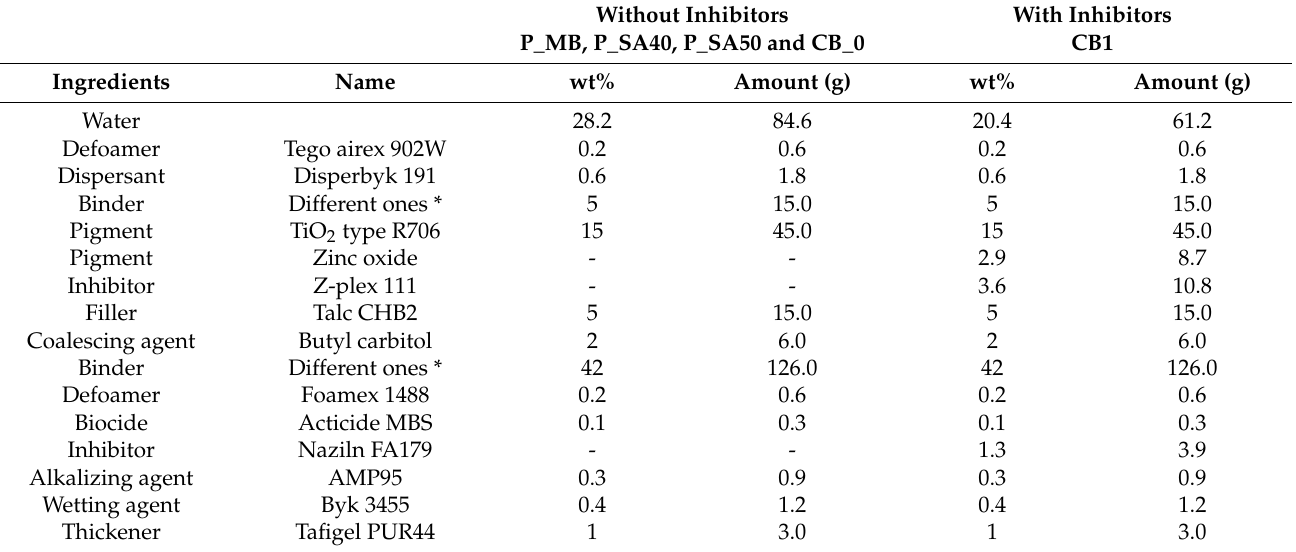
Table 1. Waterborne paint formulations with corrosion inhibitors (CB_1) and without